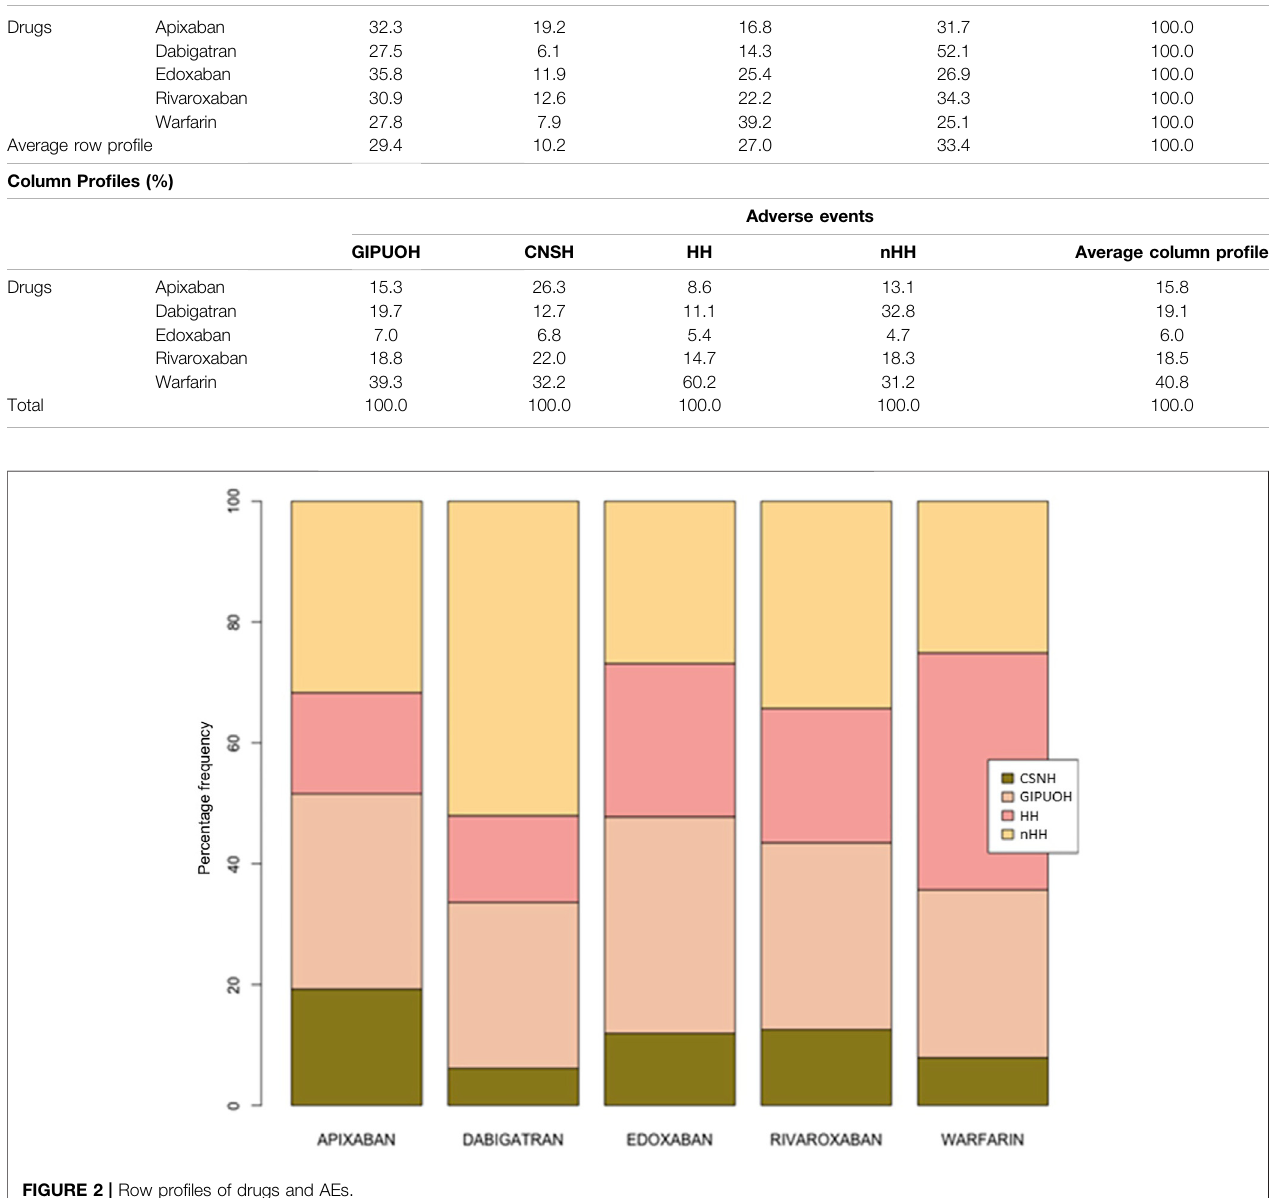
FIGURE 2 | Row pro fi les of drugs and